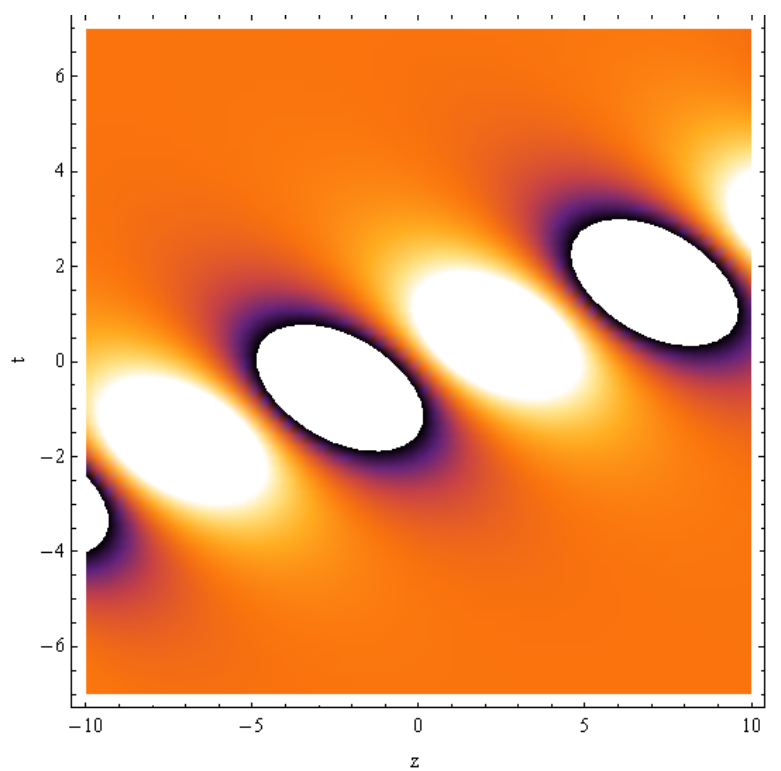
Figure 1. Change of real part of solution (18) with z , t for c = 0.5, v = 0.7, β 1 = 0.1, β 2 = 1, β 1 = 0.1, β 3 = 0.3, β 4 =